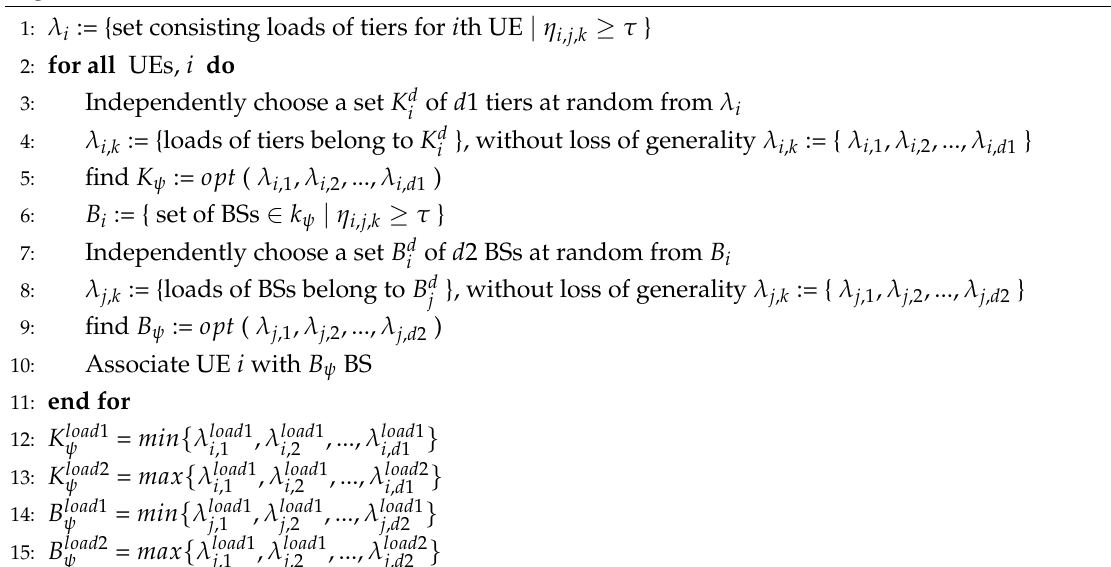
Algorithm 3 Two-level d -choices